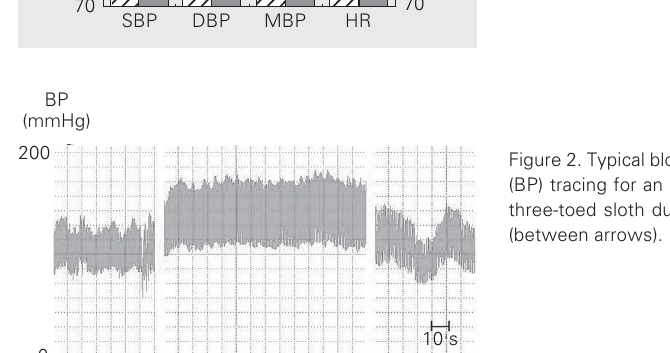
Figure 2. Typical blood pressure (BP) tracing for an unrestrained three-toed sloth during feeding (between